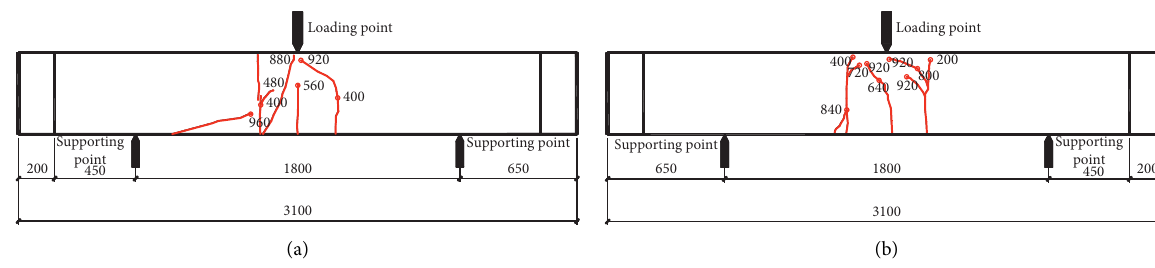
Figure 13: Crack distribution of SC-P1. (a) Crack distribution on Side A and (b) crack distribution on Side B.